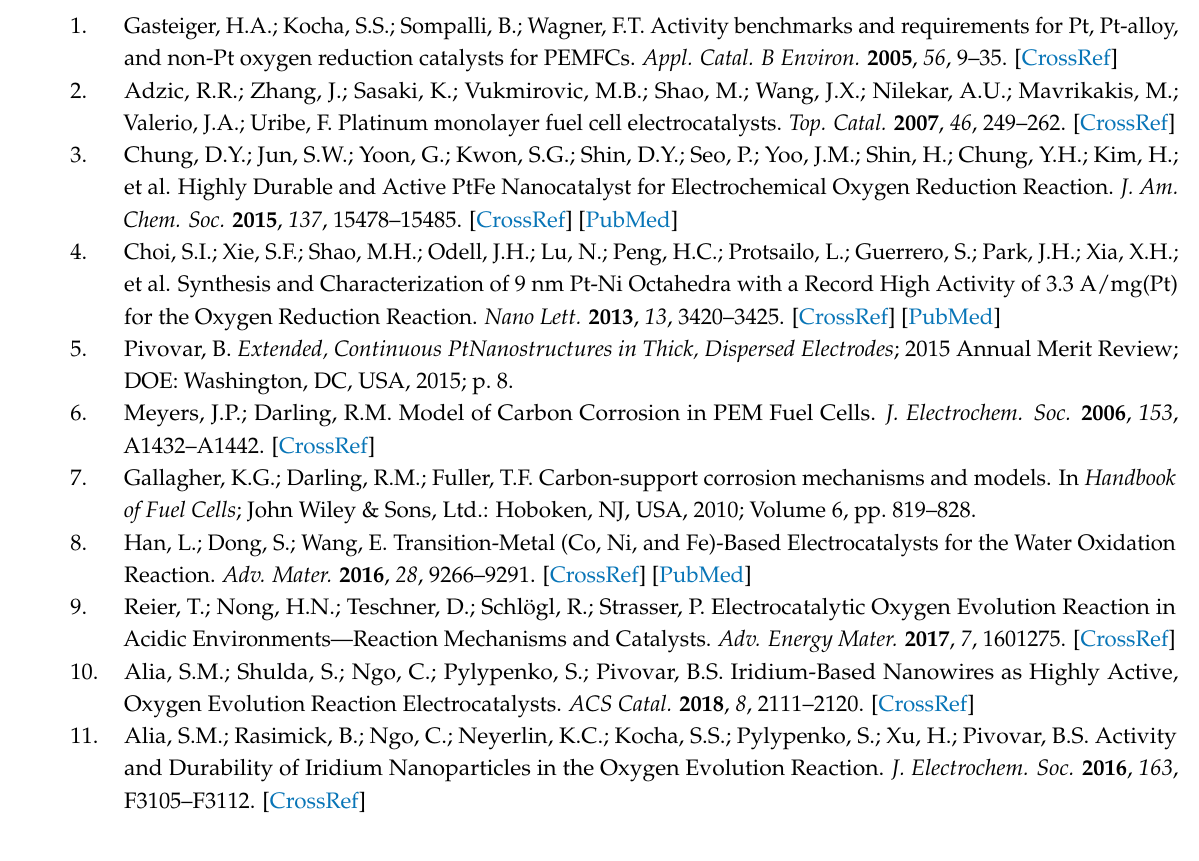
Table S1: Experimental set-ups for ORR test and accelerated durability test, Table S2: Experimental procedures for ORR test, Table S3: Experimental procedures for accelerated durability test, Table S4: Pt ion concentration determination, Figure S1: XRD patterns of two commercial iridium oxides, Figure S2: Stripping voltammogram for Pt concentration determination, Figure S3: Calibration line for Pt concentration determination using the peak current at − 0.83 V, Figure S4: TEM image of Co-Pt bronze after ADT. Author Contributions: Y.K. and Y.M. conceived and designed the experiments; Y.K. performed the